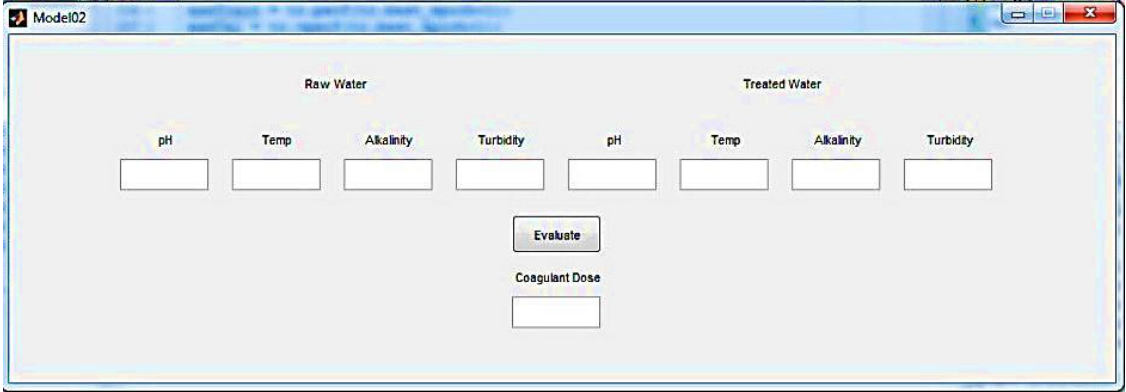
Figure 5. The Graphical User Interface (GUI) of the Model No. 2.